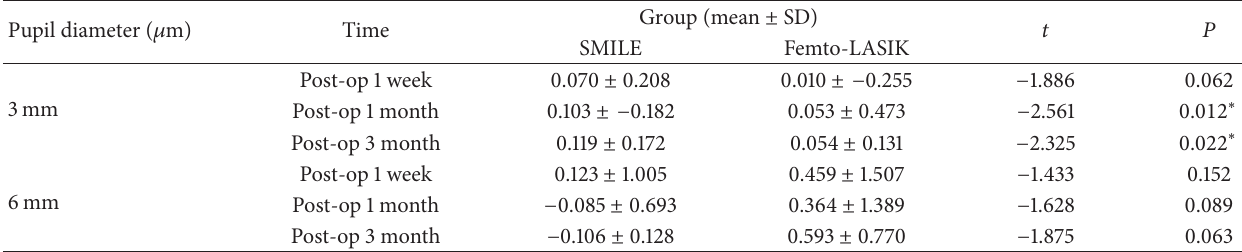
Table 2: Δ RMS at different pupil diameter between SMILE and Femto-LASIK